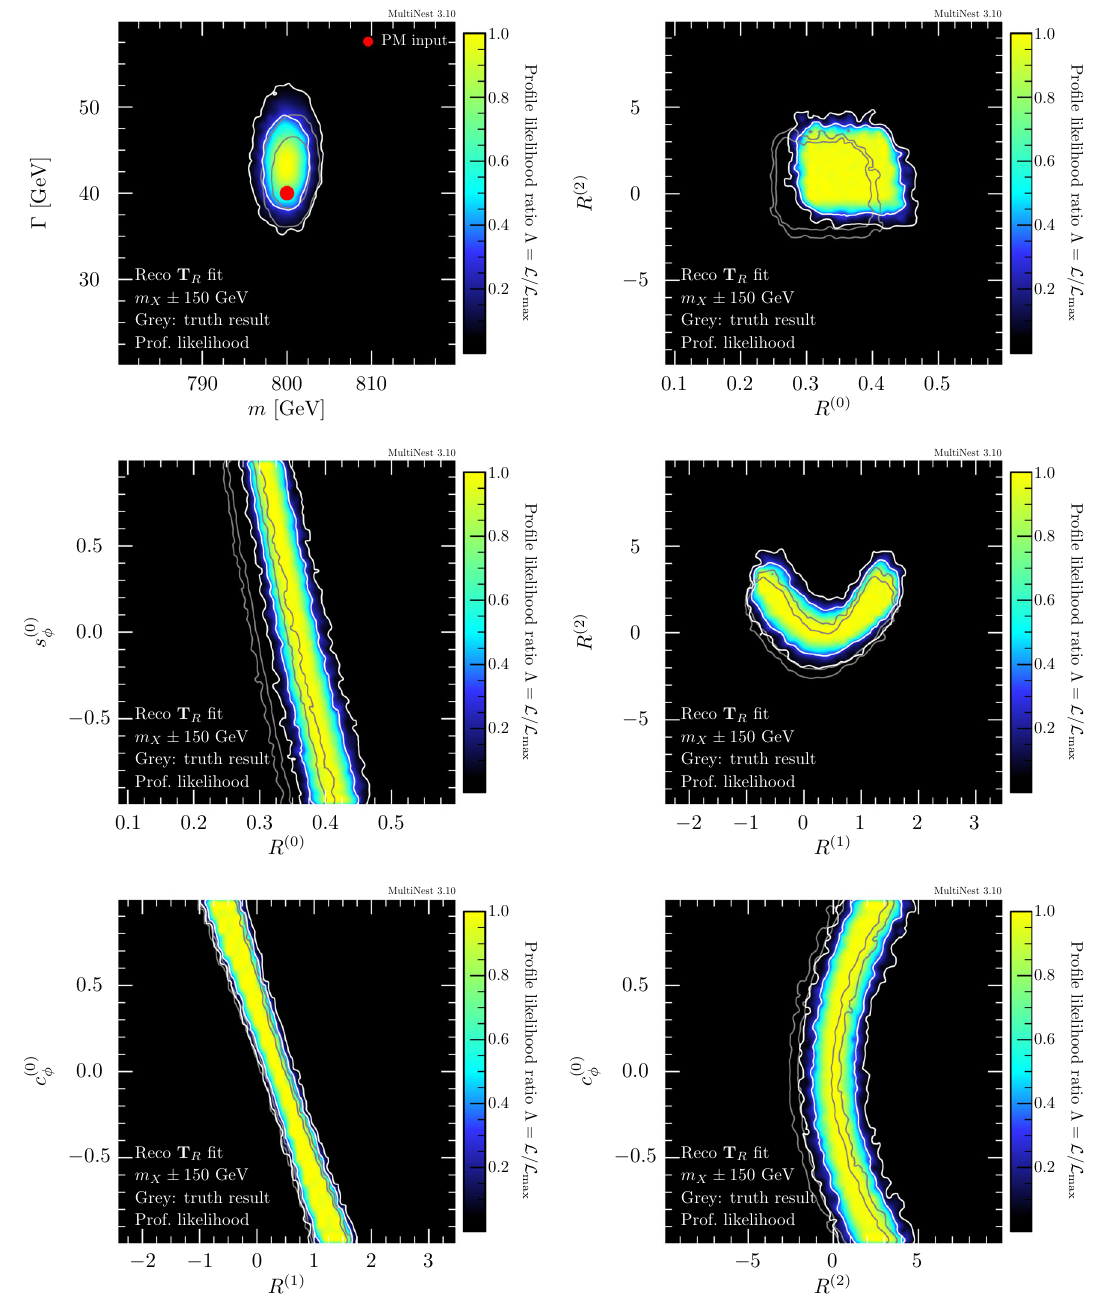
( 0 ) , s ( 0 ) ≤ 1 has been φ φ